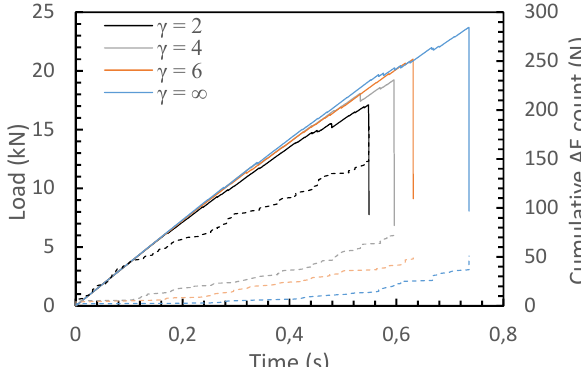
Fig. 3. Load and AE count as a function of time from agglomerate tests.